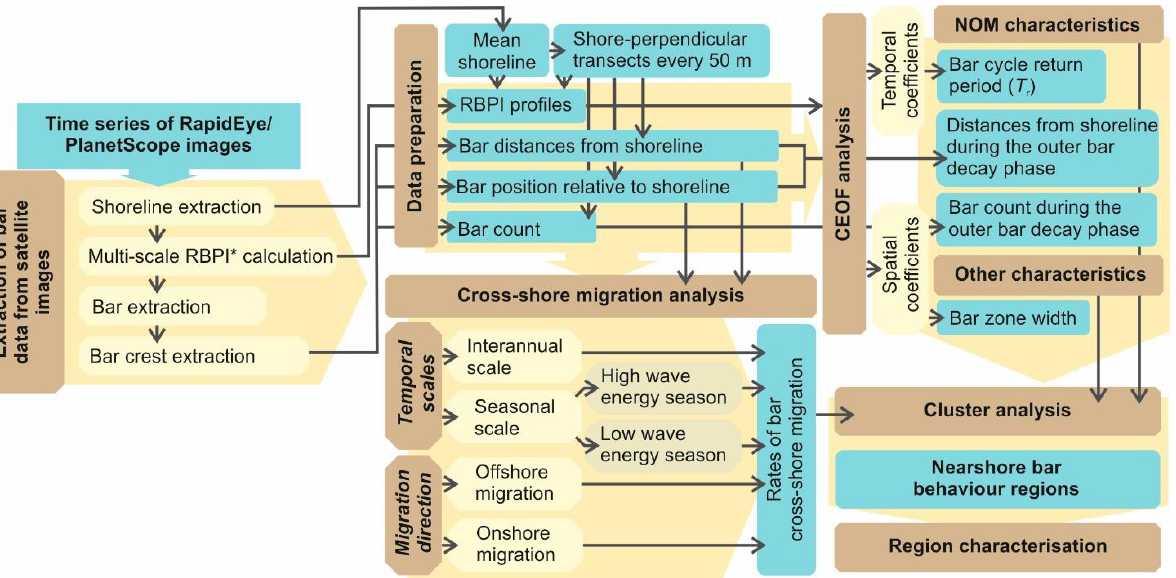
Figure 2. Flowchart describing the process of nearshore bar data extraction and analysis (RBPI* — Relative Bathymetric Position Index).